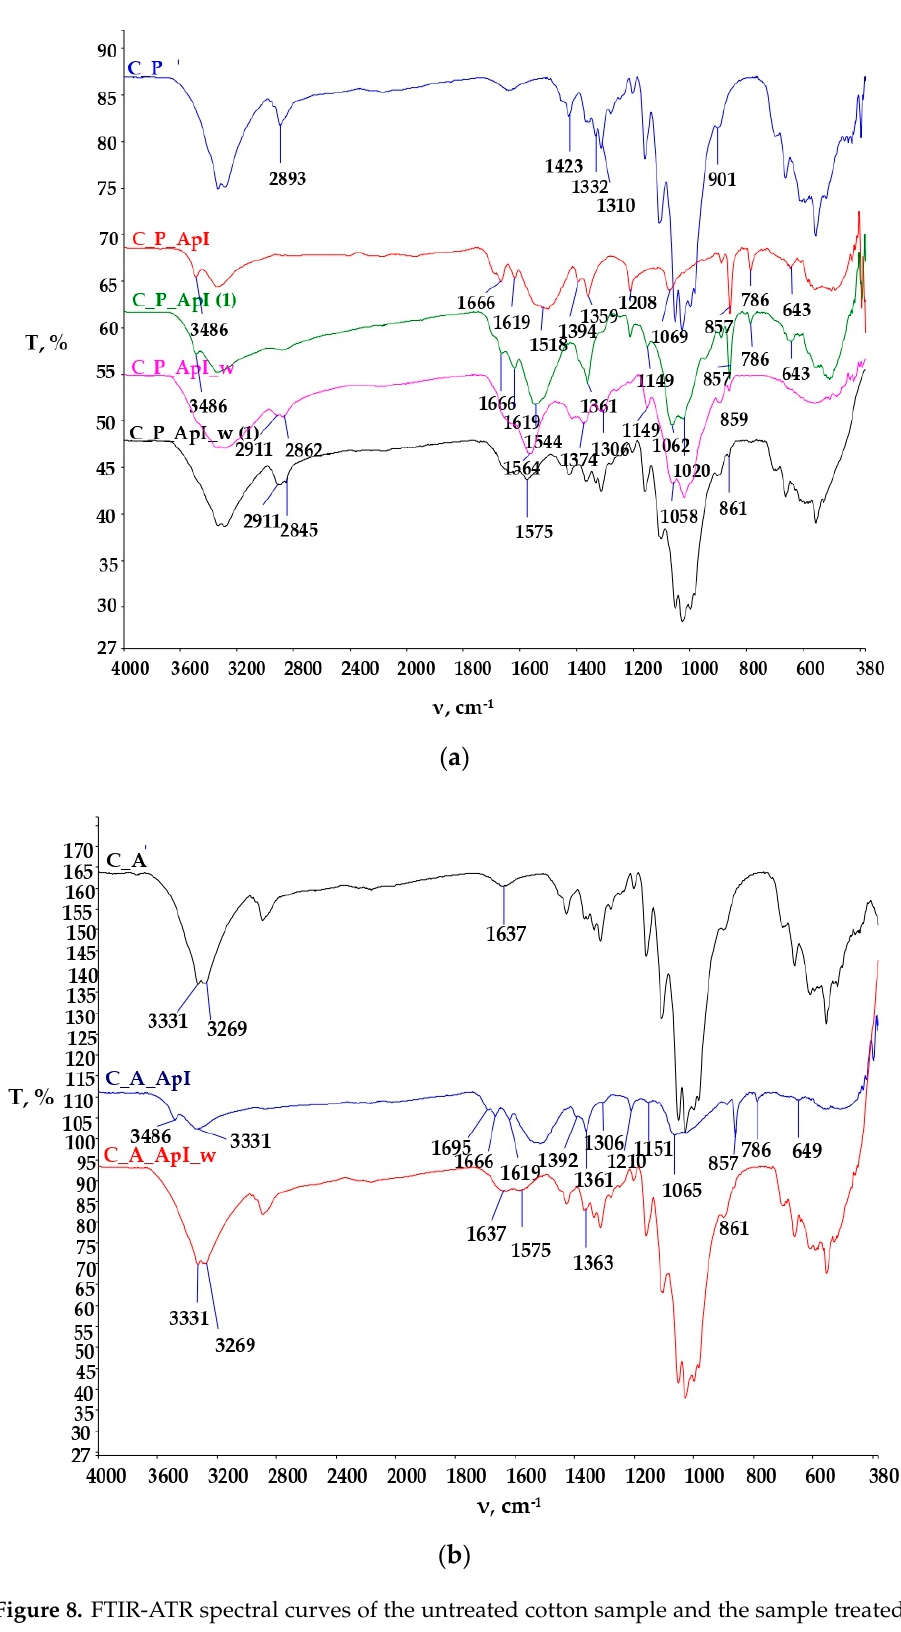
Figure 8. FTIR-ATR spectral curves of the untreated cotton sample and the sample treated in ApI before and after the care cycle (ApI_w): ( a ) in the plain weave (C_P), ( b ) in the satin weave (C_A).